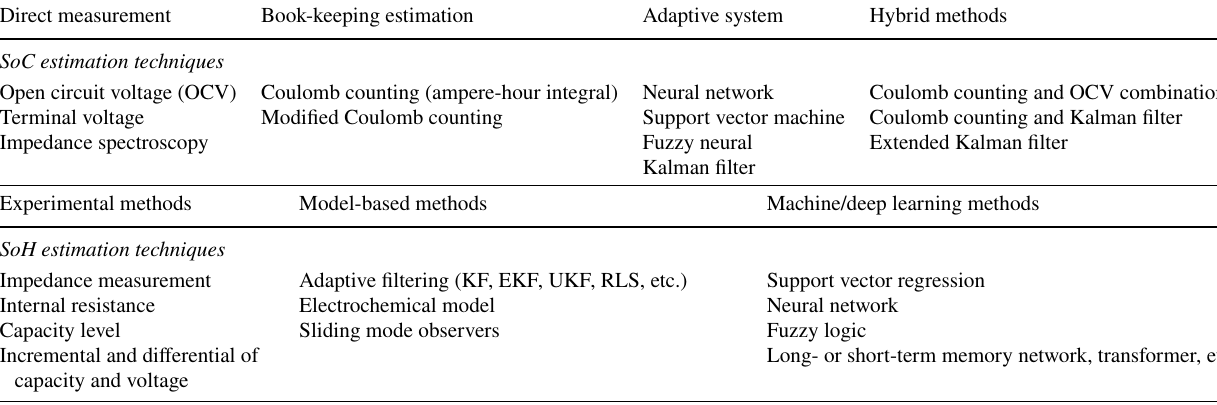
Table 1 State of Charge (SoC) and State of Health (SoH) estimation techniques Direct